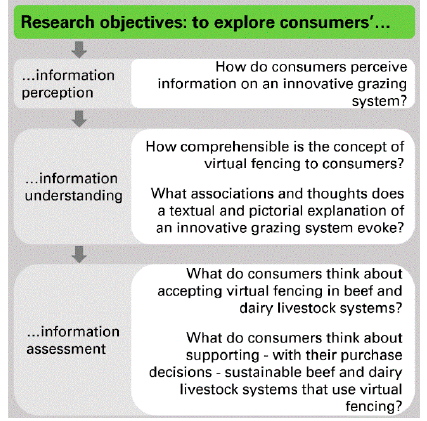
Figure 1. Research objectives and research questions.